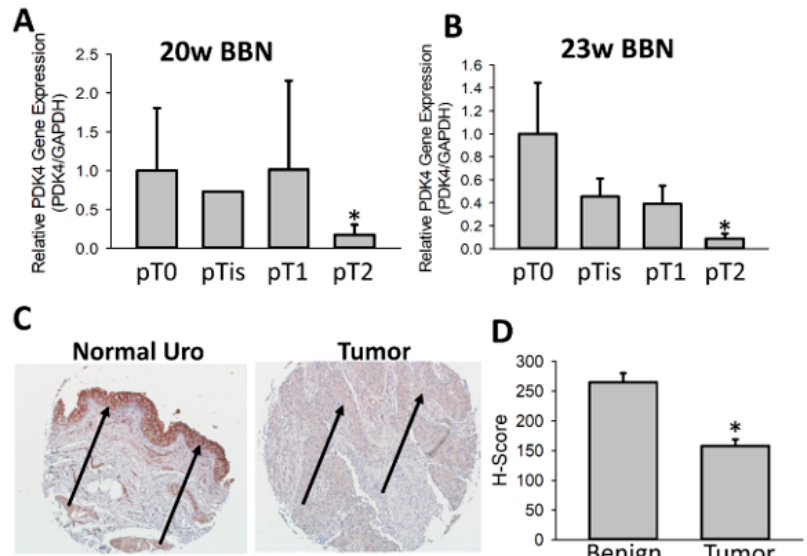
Figure 5. PDK4 is suppressed during BCa tumorigenesis. PDK4 gene expression was measured in RNA derived from WT murine tumors exposed to BBN. Tumors were delineated by stage by a board-certified pathologist to assess PDK4 expression across stages ( A , B ). A human tumor microarray was stained for PDK4 using normal ( n = 18) or tumor samples ( n = 77) ( C ). Tumors were quantified using H score ( D ). Arrows indicate urothelium/tumor. * p < 0.05.